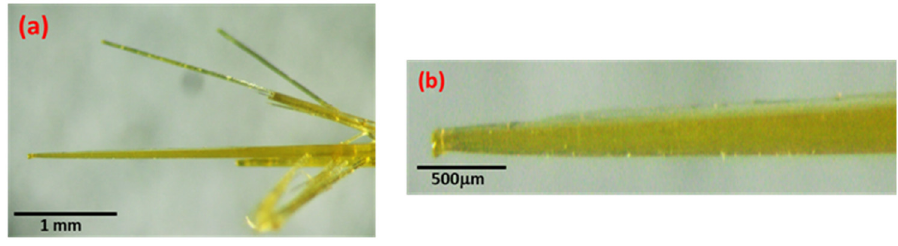
Figure 3. Optical microscopic images of grown ( a ) branches and ( b ) single SbI 3 •3S 8 crystals. To reveal the crystallinity, purity, and crystallite size of the grown crystals, we per- formed an X-ray diffraction experiment, and the results are demonstrated in Figure 4 .